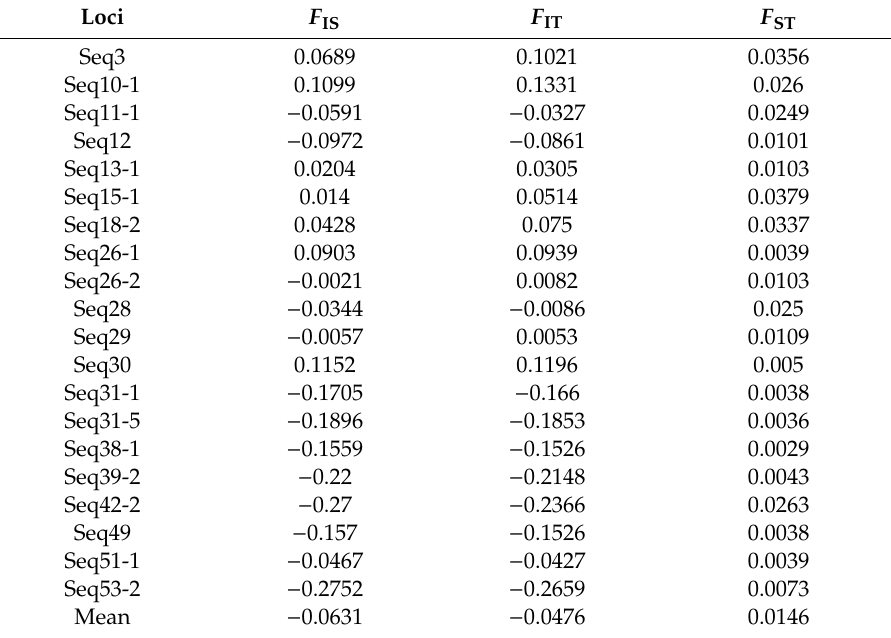
Table 3. F -statistics of 20 SNPs loci among six rare minnow populations.